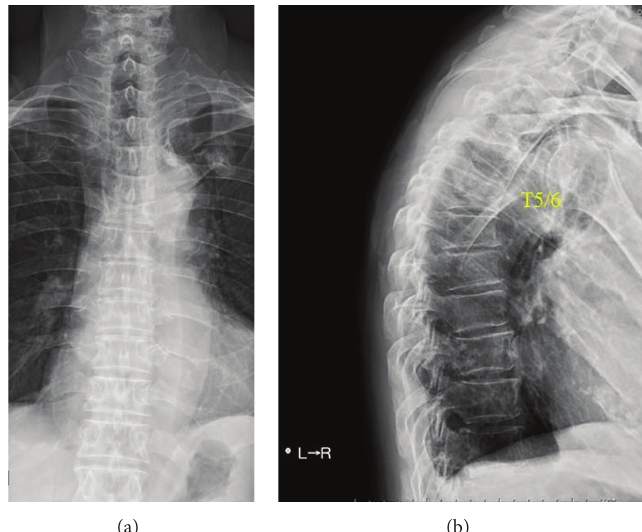
Figure 1: (a) Anteroposterior and (b) lateral radiographs of the thoracic spine show compression fractures of the T5 and T6 vertebrae.